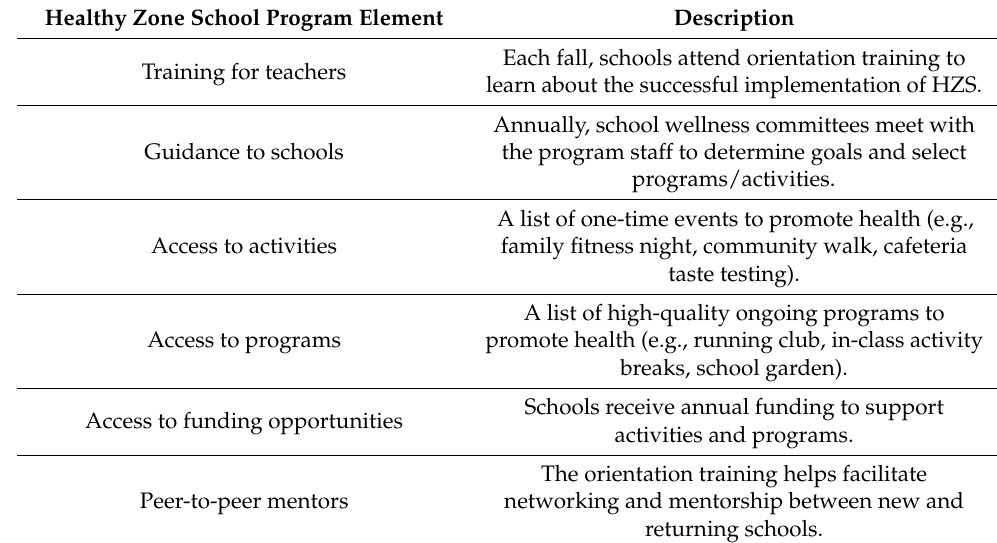
Table 1. Programmatic elements of the Healthy Zone Schools